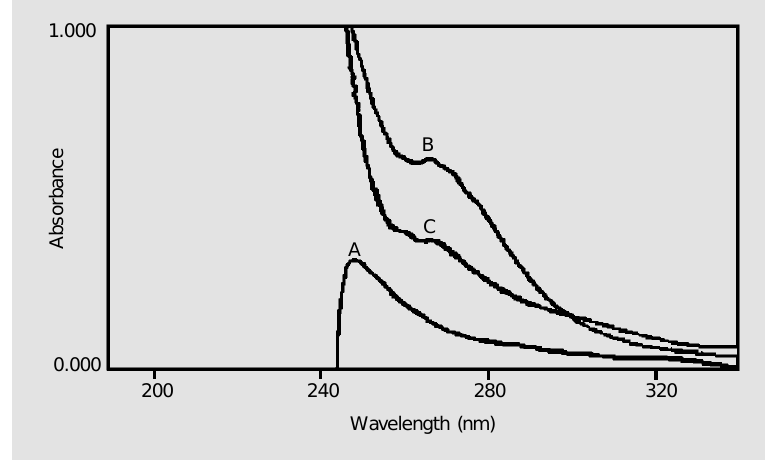
Figure 3. Characterization of the reaction of 2-methyl-2-propanethiol (t-BuSH) with the product of reaction of PhSeSePh with H 2 O 2 . Benzeneseleninic acid reacted with t-BuSH in 60% dioxane and 25 mM potassium phosphate buffer, pH 6.0. Curves: A , 20 µmol t-BuSH; B , 5 µmol PhSeO 2 H + 20 µmol t-BuSH, immediately after thiol addition; C , 5 µmol PhSeO 2 H + 20 µmol t-BuSH after 60 min. For curve A the reference cuvette contained 60% dioxane and phosphate buffer, while in curves B and C the reference cuvettes contained the same concentration of PhSeO 2 H as the sample